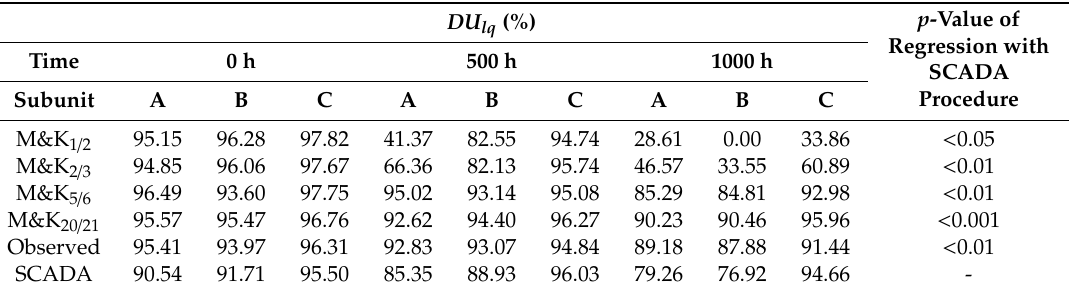
Table 4. DU lq calculated for di ff erent methods (Merriam and Keller (M&K) observed for all emitters and SCADA) for each irrigation subunit at the beginning, after 500, and 1000 h of the experiment, and its regression significance level with the SCADA